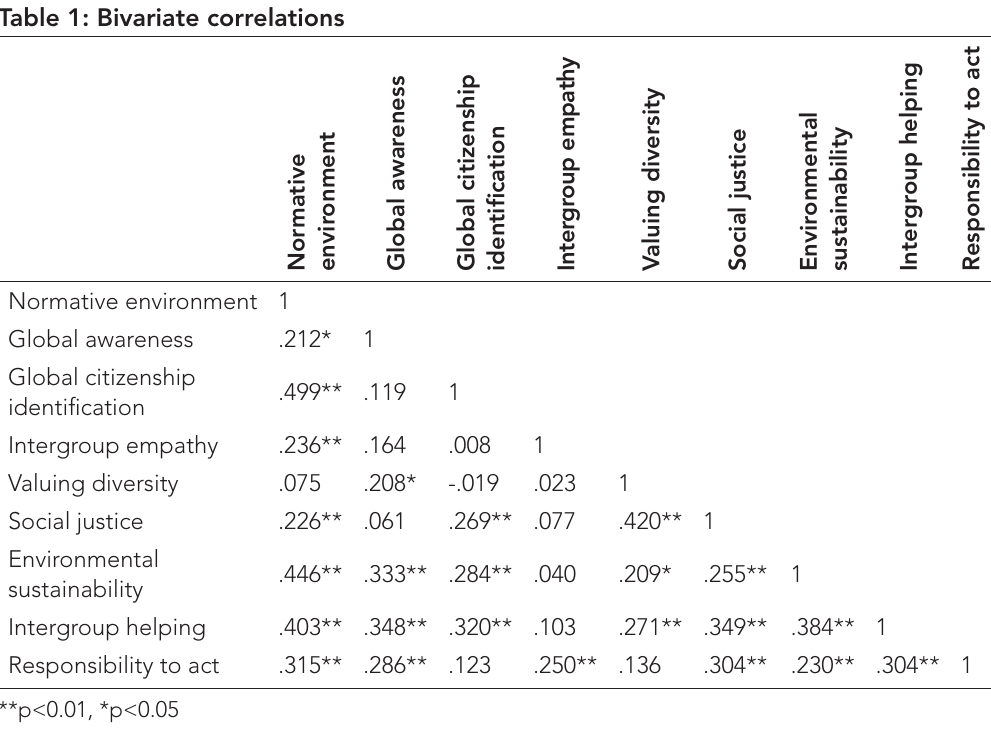
table 1: bivariate